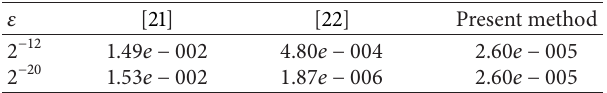
Table 2: Comparison of maximum absolute error with other methods for 𝑁 = 256